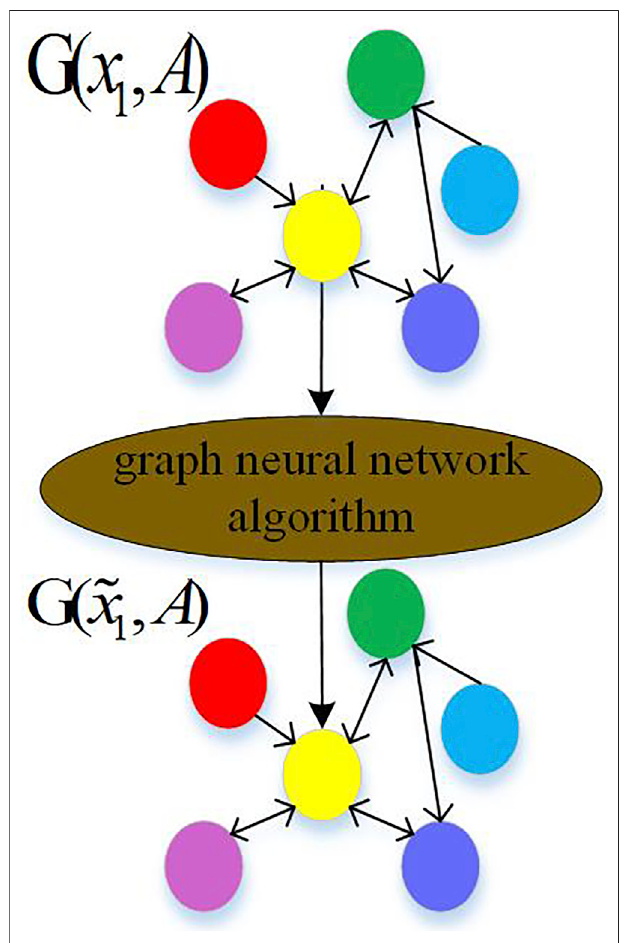
FIGURE 1 | Graph of the neural network algorithm